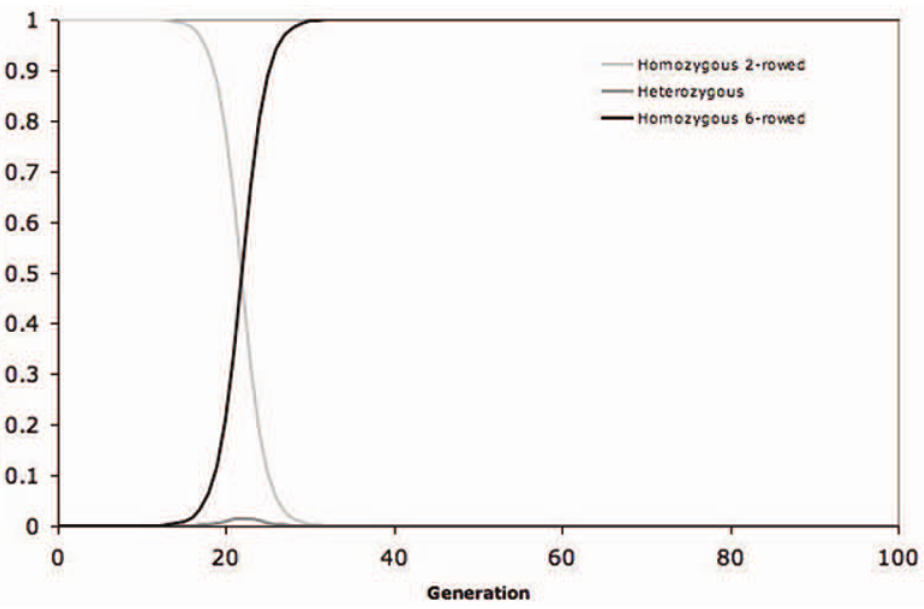
Figure 4. Six-row introduction to two-row populations. Modelling of generations to fixation of recessive six-rowed alleles in homozygous two- rowed barley crops by automatic selection using realistic constraints (Population size: 10 6 ; Out-crossing rate: 2%; Six- to two-rowed fecundity ratio: 2.0) the a six-row individual is introduced into a population of 10 6 two-row plants.